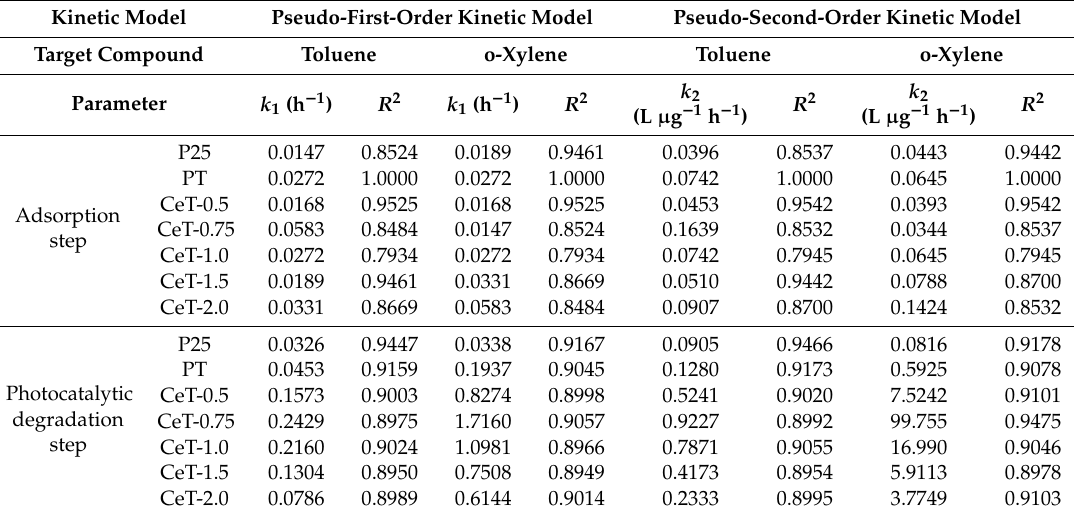
Table 2. Kinetic parameters of adsorption and photodegradation of toluene and o-xylene using Degussa